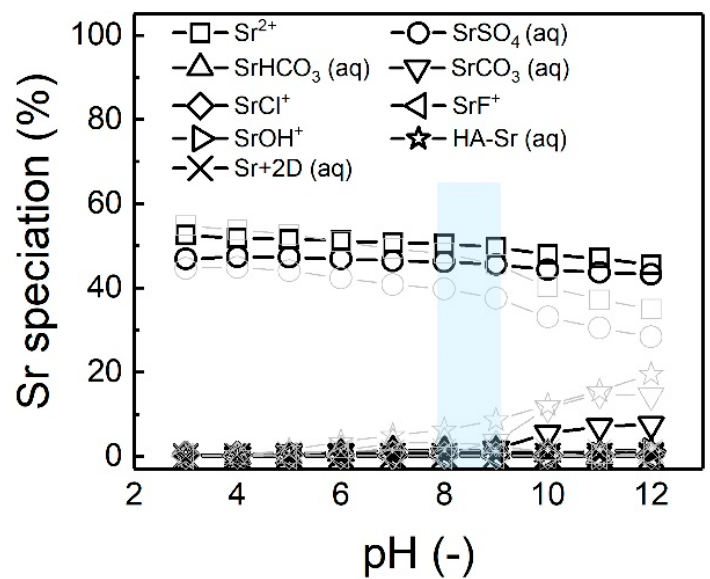
Figure 8. Strontium speciation in groundwater sample 5 and simple 1 as a function of pH (3–12), which was simulated and obtained by Visual MINTEQ. The light blue area represents the pH range of groundwater samples 1–5; light grey data points are Sr speciation in sample 1 as a function of pH.